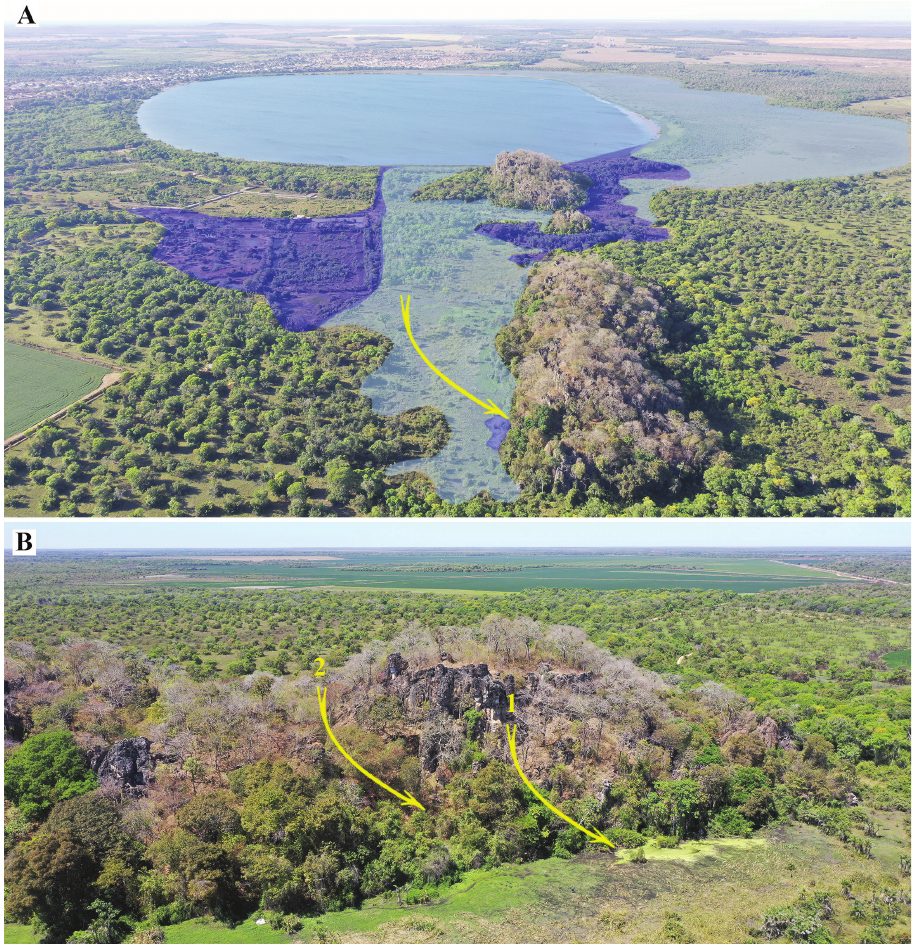
Figure 34. Lagoa da Confusão karst area A limestone outcrops close to the Lagoa da Confusão karst lake. The dark blue indicates the floodplain (not flooded in the moment of the photograph) and the dark blue indicates those flooded areas. The arrow indicates the main entrance of the Casa de Pedra cave B outcrop where the Casa de Pedra cave is located; 1. indicates the main entrance of the cave; 2. Upper